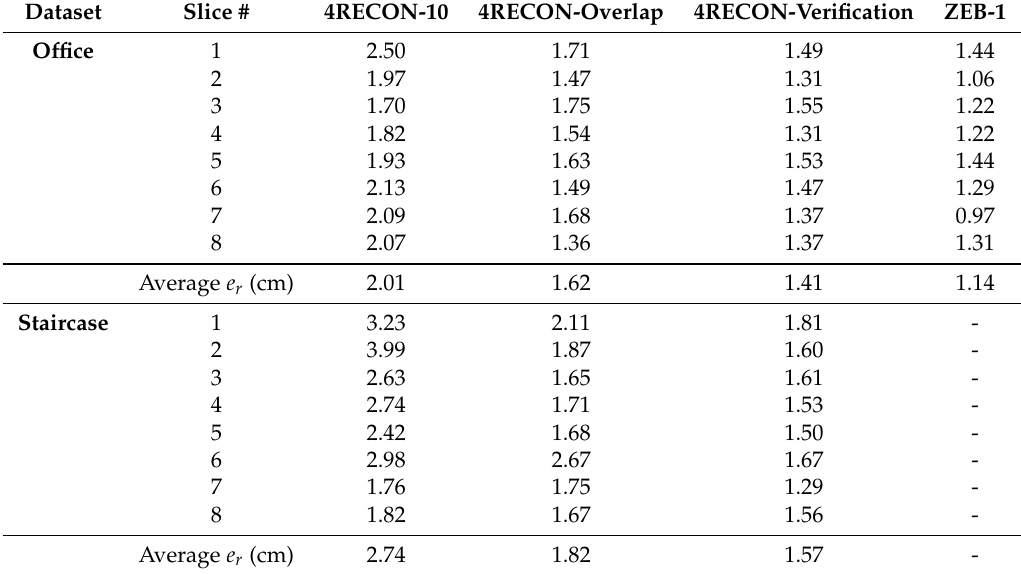
Table 3. Relative error e r of our method and ZEB-1 product within selected slices visualized in Figure 20. Presented values are average displacements (cm) of the points comparing with the ground truth point cloud obtained by FARO static scanner. The results are missing for ZEB-1 and Staircase dataset since there was no reconstruction using this scanner